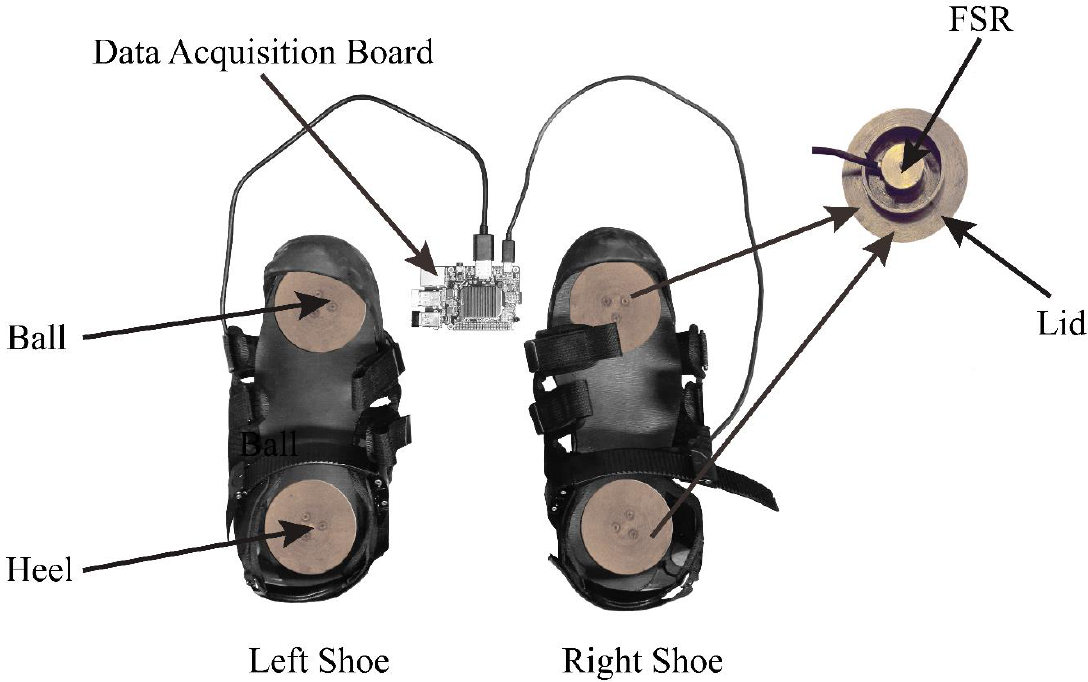
Figure 1. FSRs placed inside each shoe in the ball and in the heel and a data acquisition board is used to collect the GCF signal.